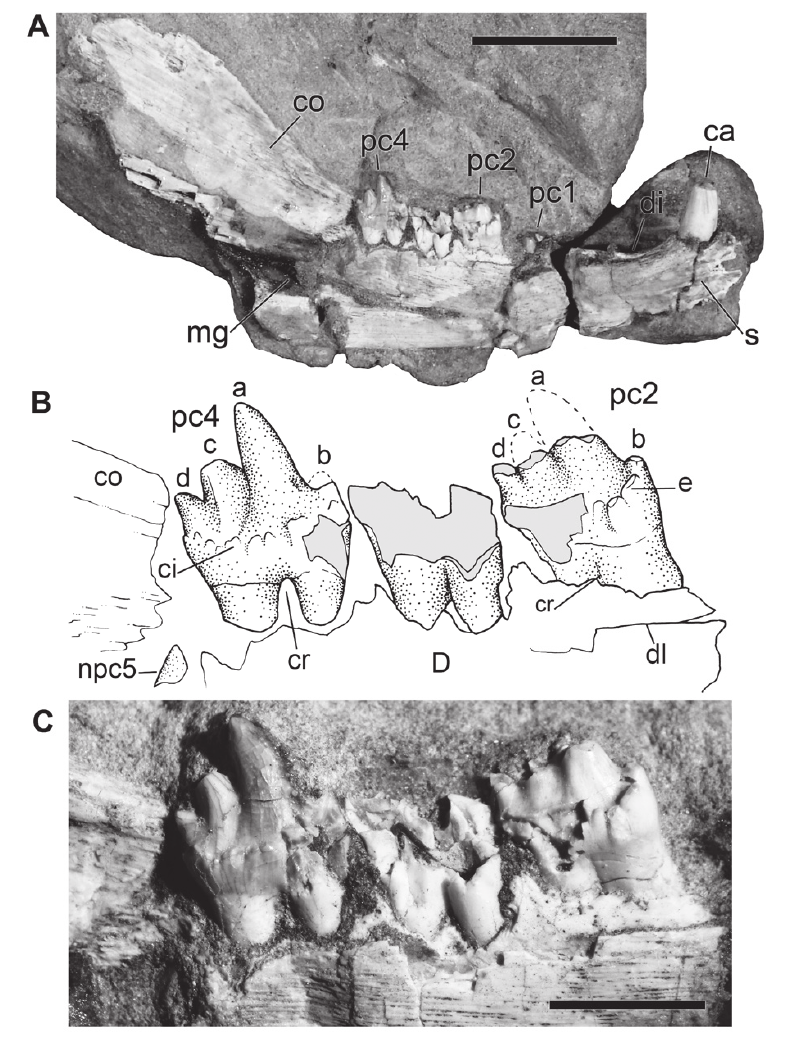
Fig. 4 - Holotype (MMACR-PV-003-T) of Botucaraitherium belarminoi gen. nov. et sp. nov. A: Left lower jaw in medial view. B and C: detail of the postcanines in medial view. Scale bar equals 10mm in A and 3mm in B . Gray areas indicate broken surfaces. Abbreviations: a-e , refers to name of cusps; ca , canine; ci , cuspidated cingulum; co , coronoid process of dentary; cr , constricted root; D , dentary; dl , dental lamina; mg , meckelian groove; npc5 , non-erupted postcanine 5; pc , postcanine; s ,